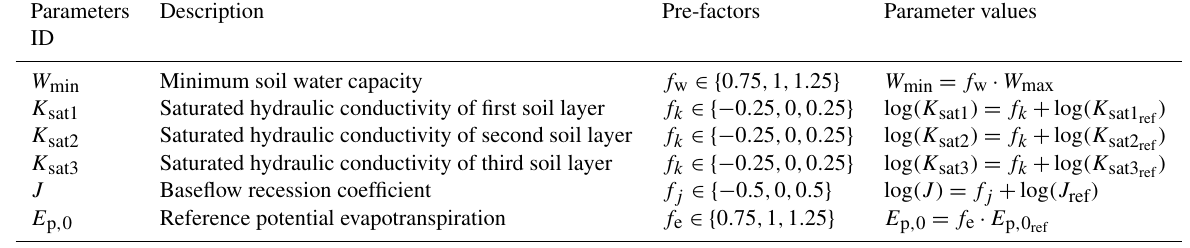
Table 3. Parameter values used in the calibration processes.